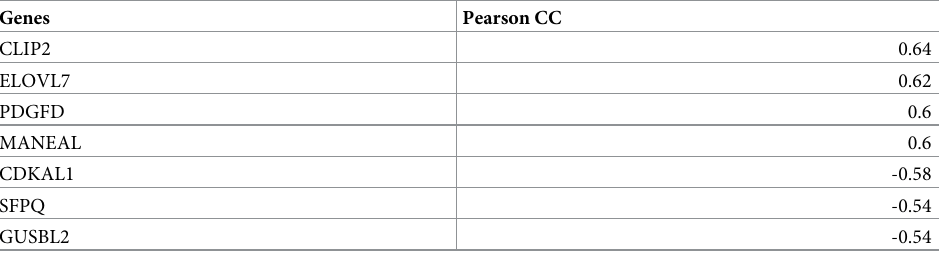
Fig 3. The expression profiles of CHST4, CLIP2, ELOVL7, PDGFD, MANEAL, CDKAL1, SFPQ and GUSBL2 were all statistically significant (Fig 4). Table 2. Six correlated genes of CHST4 from the